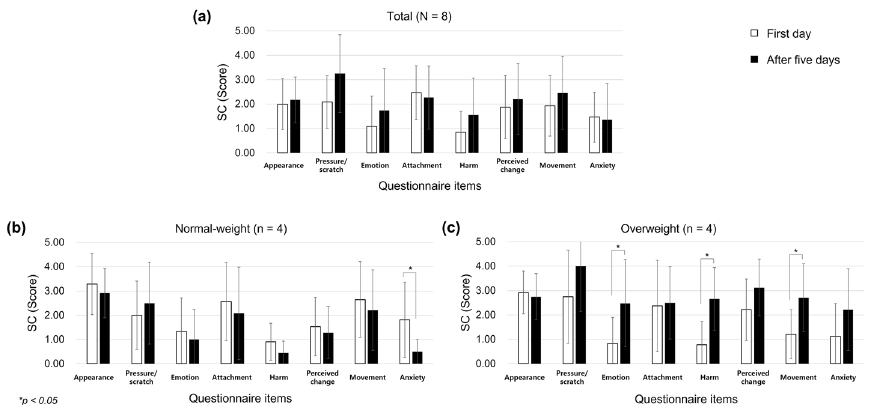
Fig. 6 Results of subjective evaluation by questionnaire